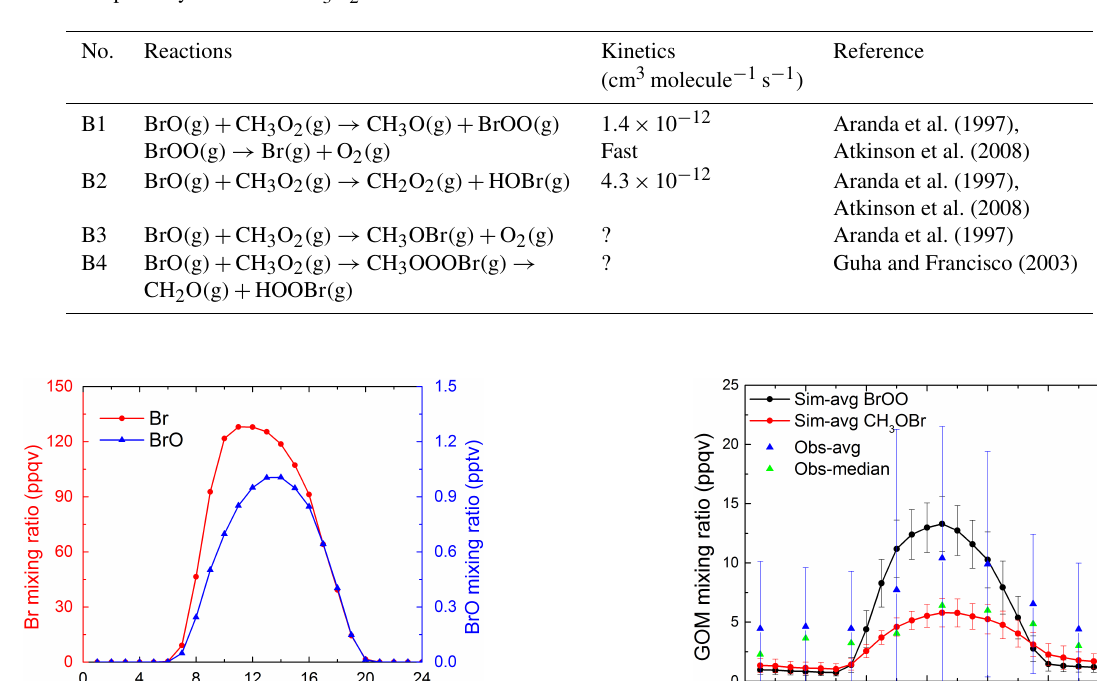
Table 4. Possible pathways of BrO + CH 3 O 2 reaction.